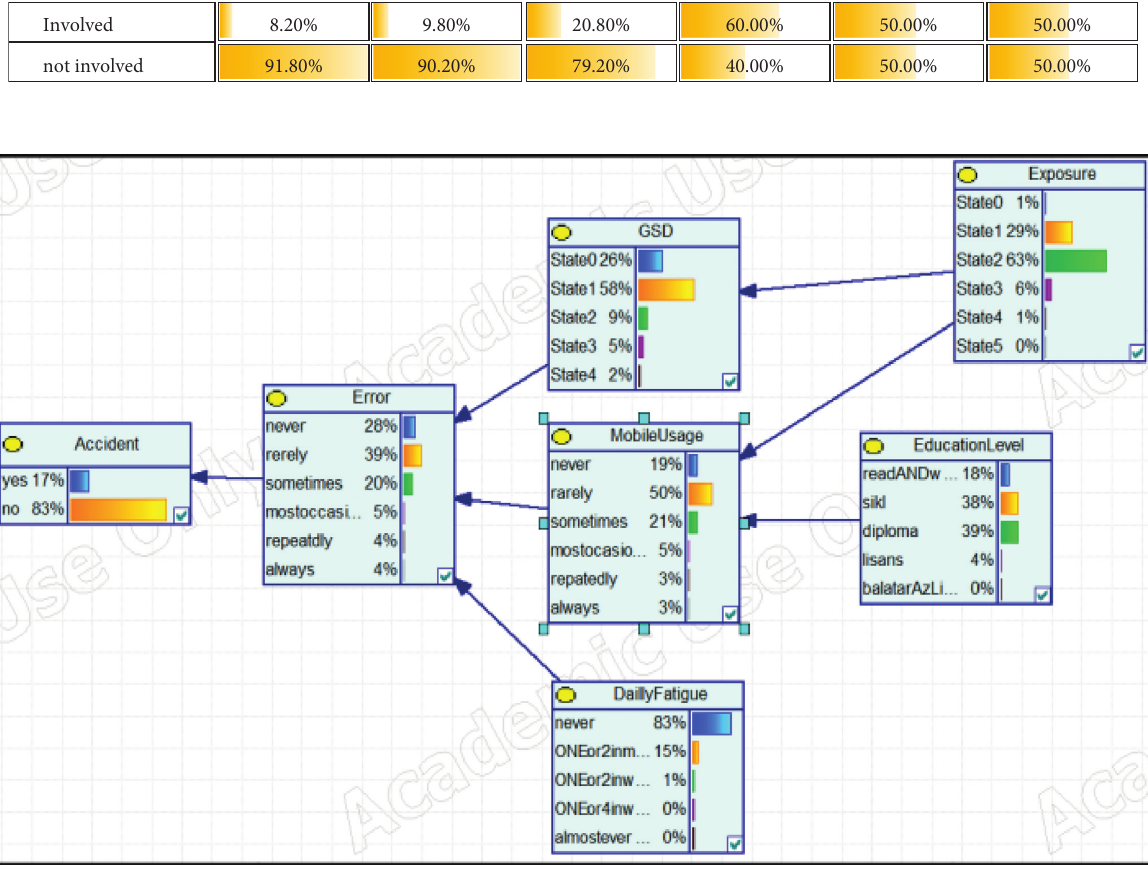
Figure 4: The distribution of conditional probabilities of the BN for the database studied in this research. Table 6: The probability of the at-fault collision occurrence of heavy vehicle drivers for each variable.